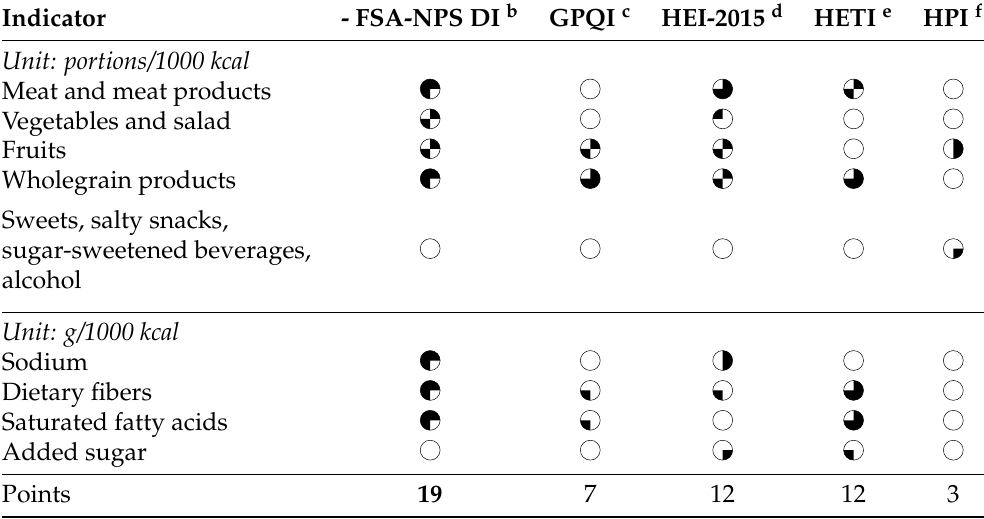
Table 7. Discrimination potential of relevant food shopping quality indicators to differentiate health- relevant individual daily nutritional intake a behavior ( relative , i.e., calorie-adjusted), N = 89.